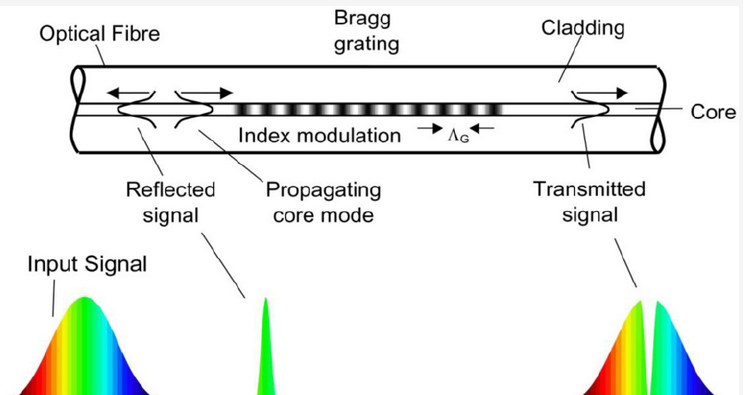
Figure 9. The fiber Bragg grating (FBG) is a wavelength-dependent light filter obtained by creating a periodic refractive index grating, with spacing of the order of a wavelength of incident light, within the core of an optical fiber. If monochromatic light is sent through the grating, the total reflection condition is satisfied when λ B = 2 n Λ , where n is the effective refractive index of the grating, λ B is the Bragg wavelength, and Λ is the period of the grating. If a polychromatic light beam is sent to the grating, a reflected spectrum whose centre wavelength is λ B is reflected and the remaining portion of light is transmitted. Since the grating period is dependent on the operative temperature and on the deformation of the fiber, the measurement of the shift of Bragg wavelength can be used to sense strain and temperature with a great accuracy. Reproduced from